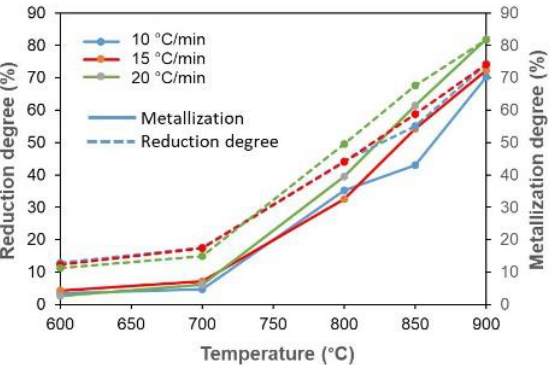
Figure 10. Reduction and metallization degrees of the iron ore-biomass pellets with temperature and heating rate variations.